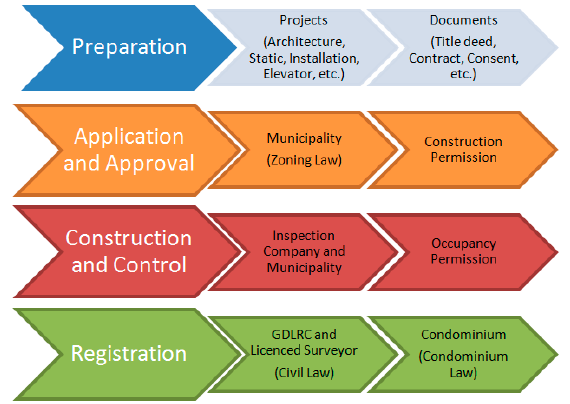
Figure 3. Process for forming property rights for individual units in Turkey.